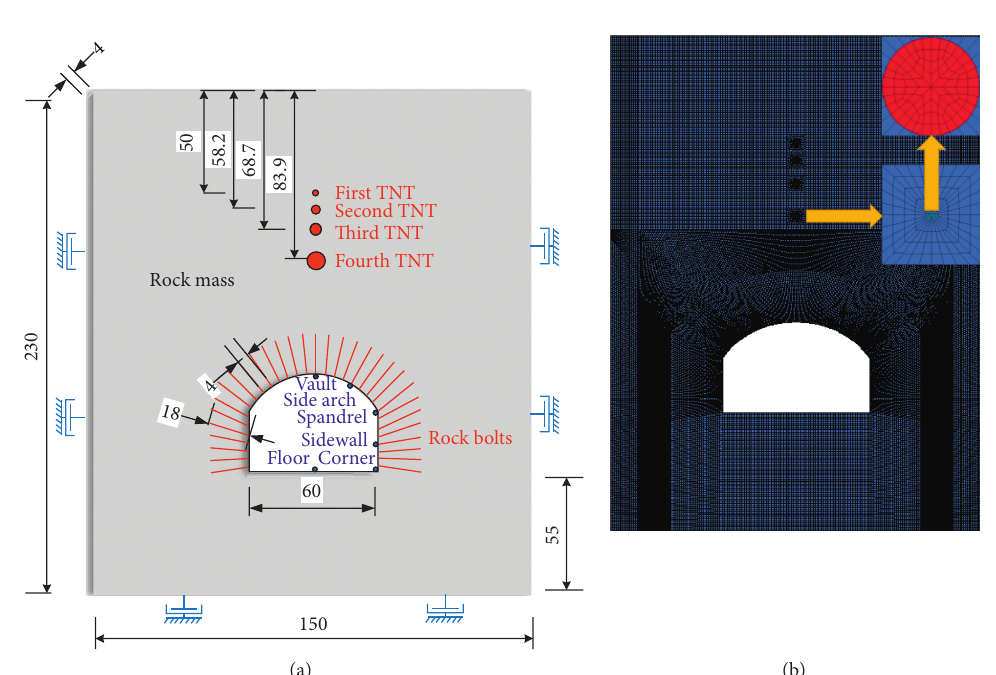
Figure 2: Model of numerical analysis. (a) Geometry of the model (unit: cm). (b) Mesh of the